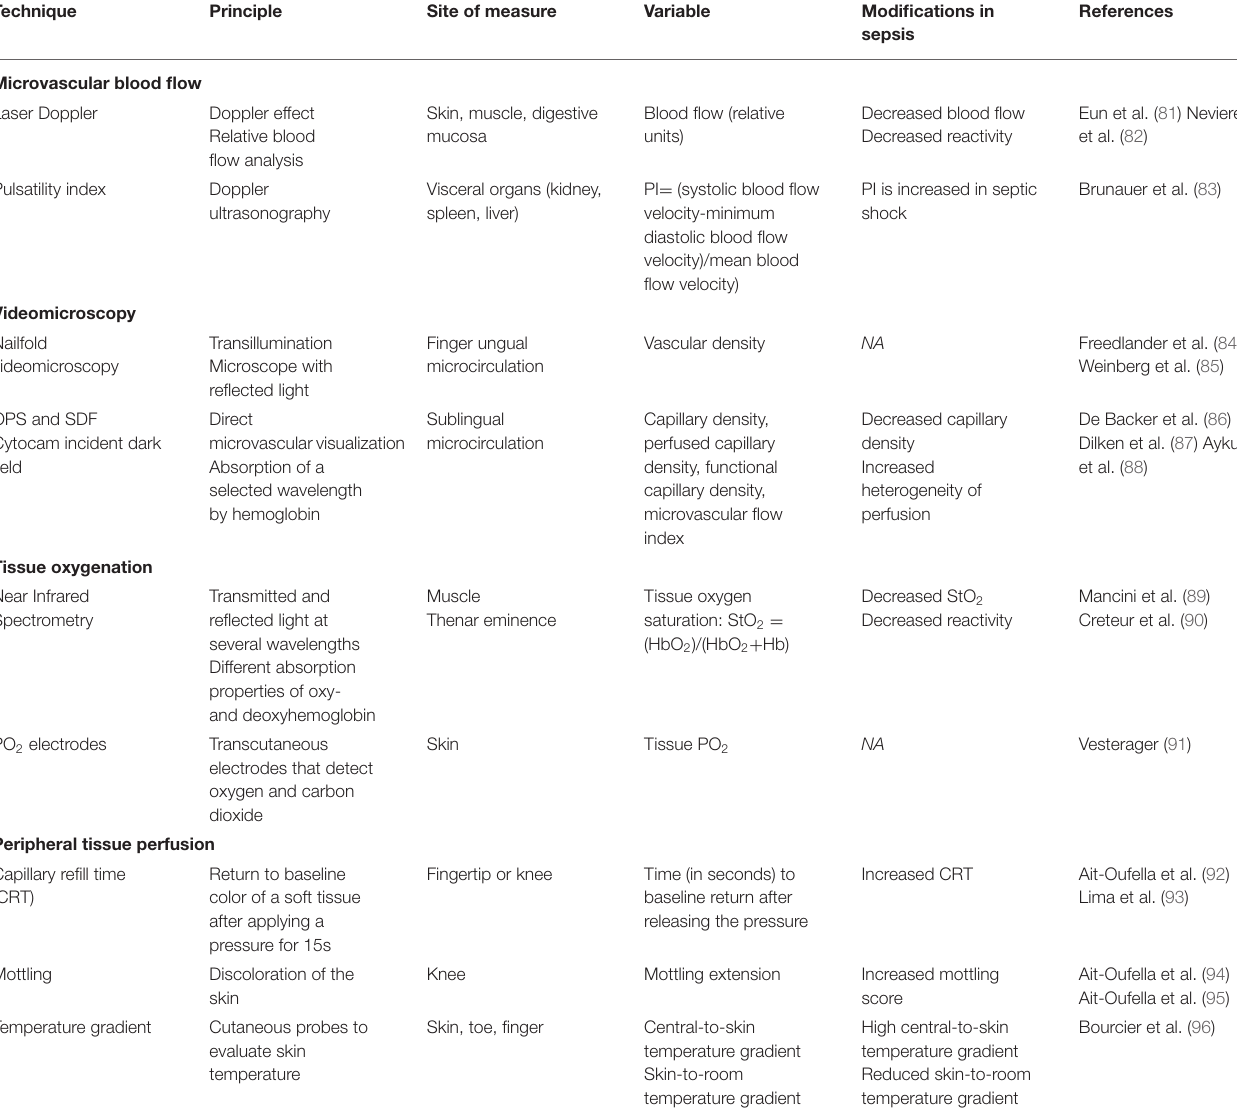
TABLE 1 | Assessment of microcirculatory disorders in critically ill